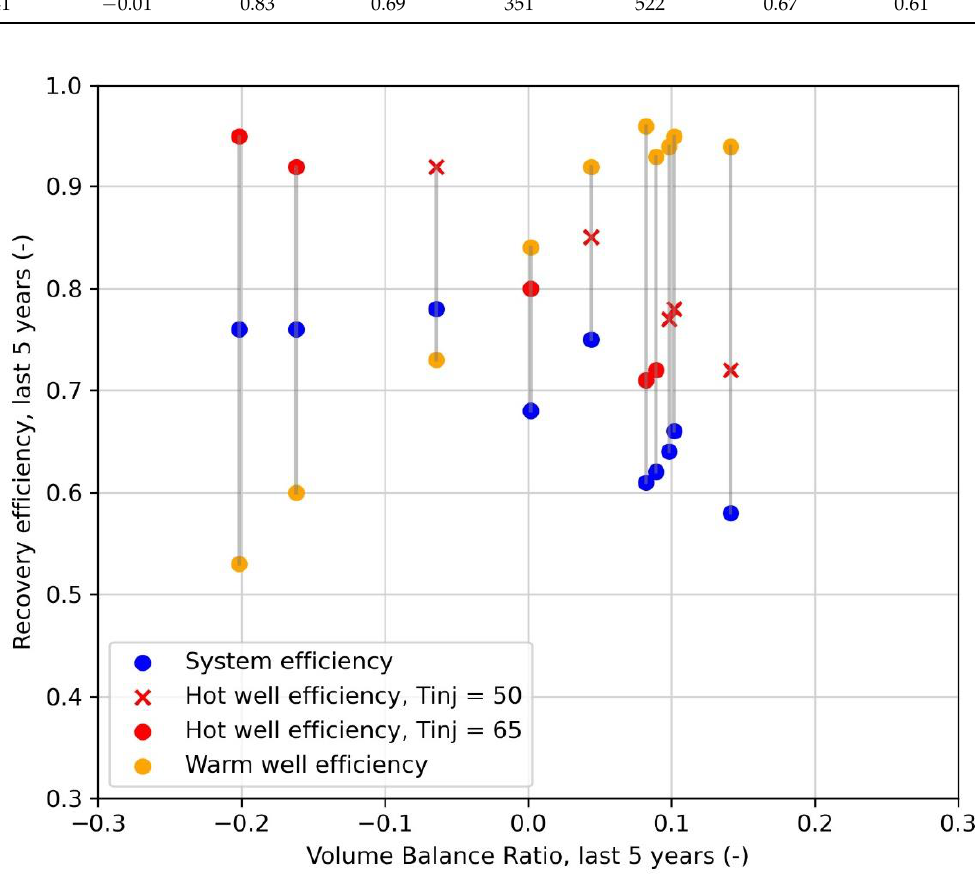
Figure 8. HT-ATES System, hot well and warm well recovery efficiency (last five years) (y-axis) vs. the volume balance ratio ( r VB ) during the last five years (x-axis) for the ten modelled scenarios. The average recovery efficiency during the last five years of simulation is shown to take out any effects of the first start-up years of HT-ATES operation.